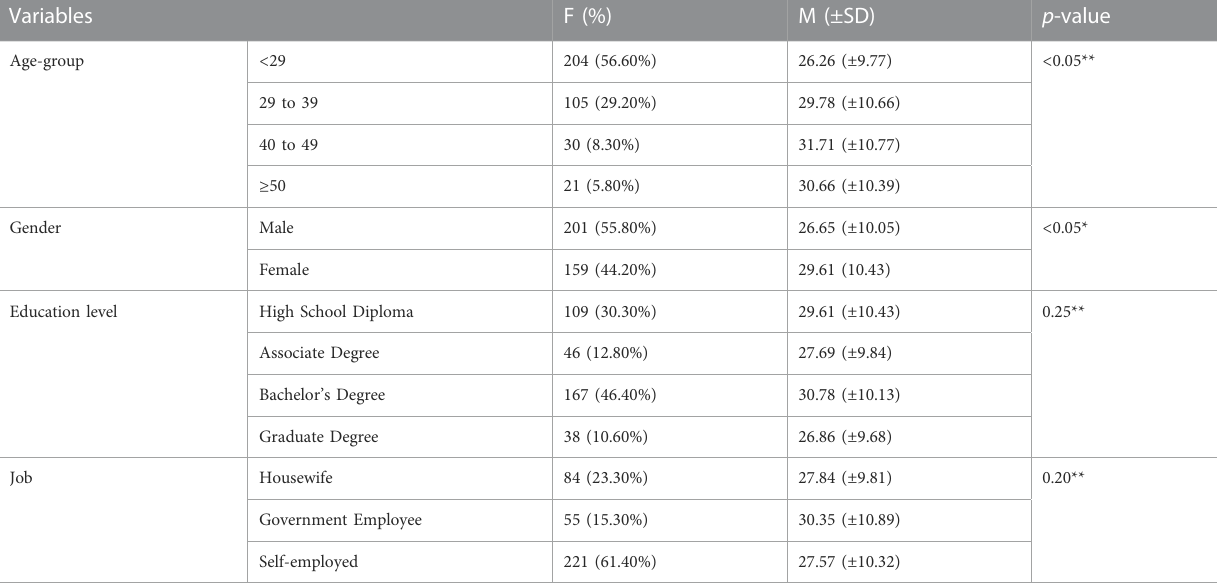
TABLE 2 Means and standard deviations by selected demographic characteristics for waste separation behavior.